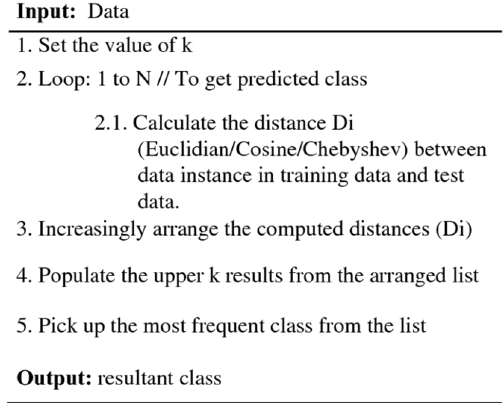
Fig. 4 Decision tree pseudocode [18]